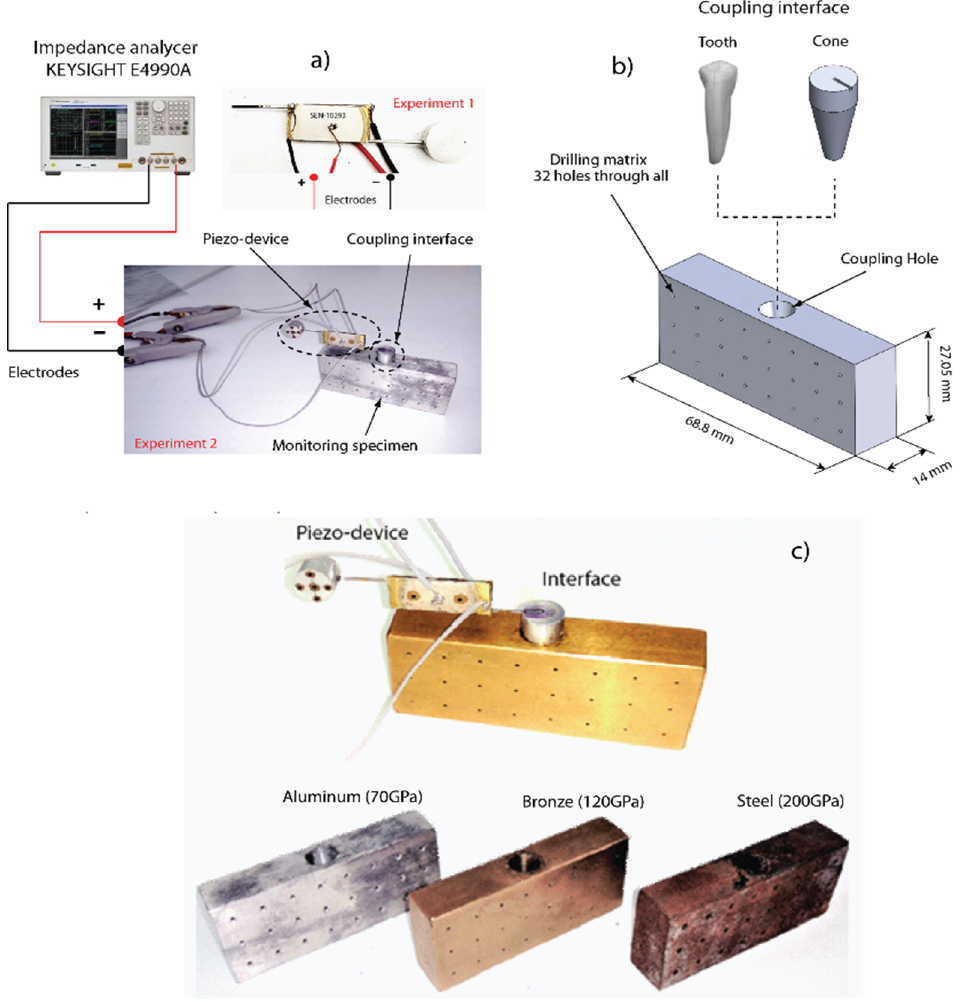
Figure 4. ( a ) Experimental setup for electromechanical impedance measurements. ( b ) Dimensions and materials for the monitoring structure including the coupling interface. ( c ) Materials for the experiment.